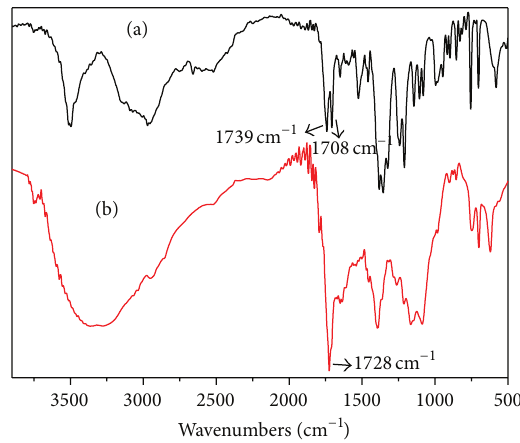
Figure 2: Infrared spectra of (a) BMD and (b) after ring-opening polymerization.